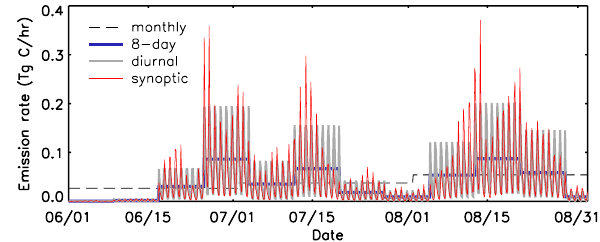
Fig. 1. GFEDv2 time series of total biomass burning emission rates (TgC/hr) in North America (180 ◦ –60 ◦ W; 30 ◦ –80 ◦ N) for June– August 2004. GFEDv2 inventories with monthly , 8-day , diurnal , and synoptic variations are